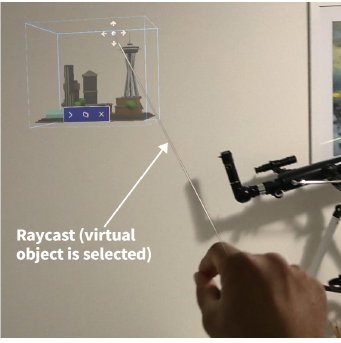
Figure 8. HoloLens